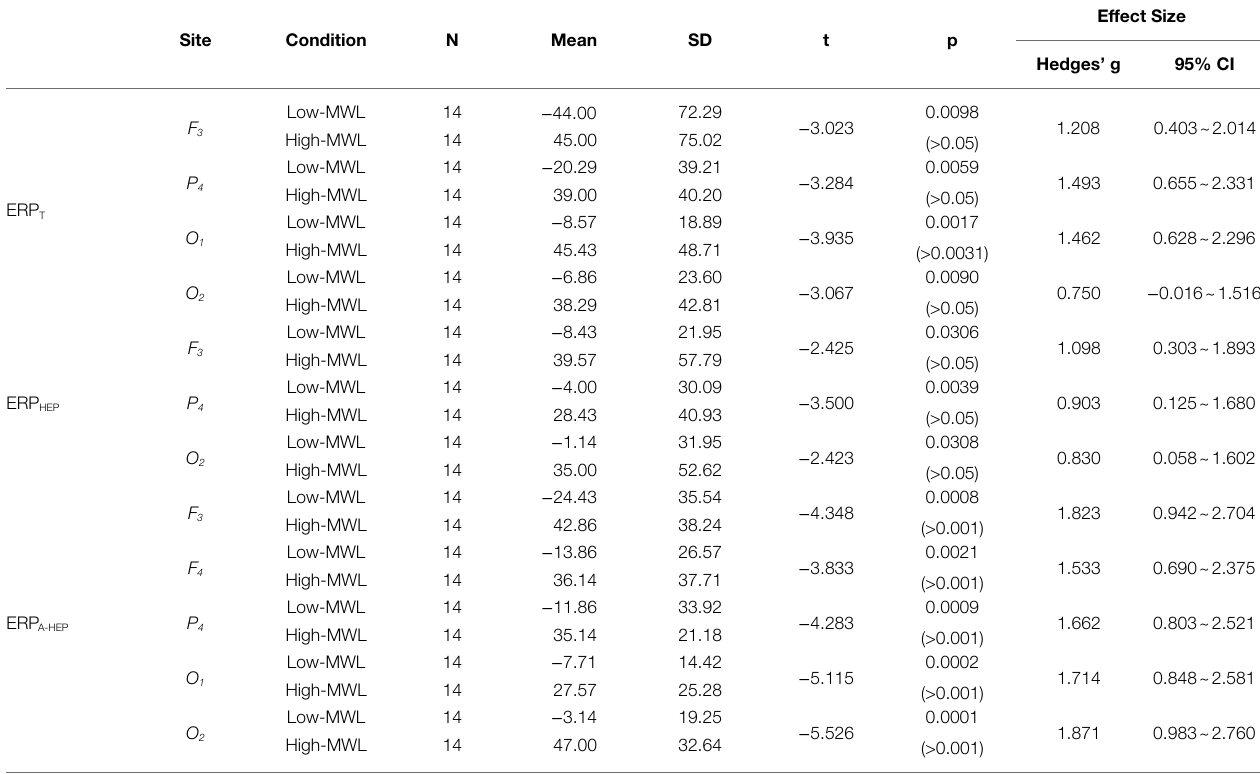
TABLE 2 | Comparison by paired t-test of the P600 latency the low- and high-MWL conditions.